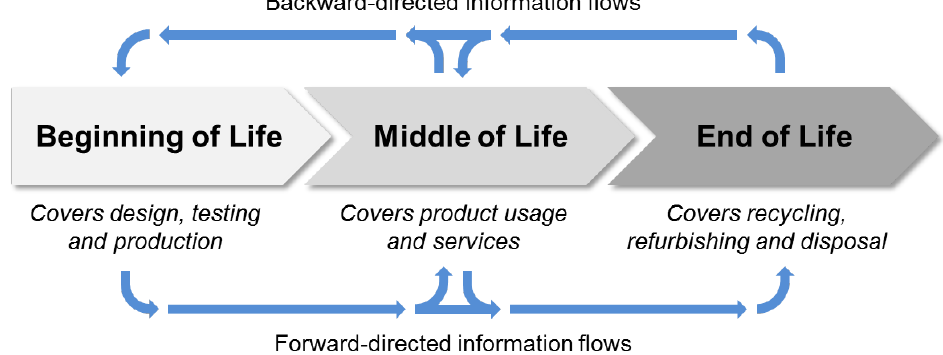
Figure 3. Model of a product lifecycle and important information flows [18].